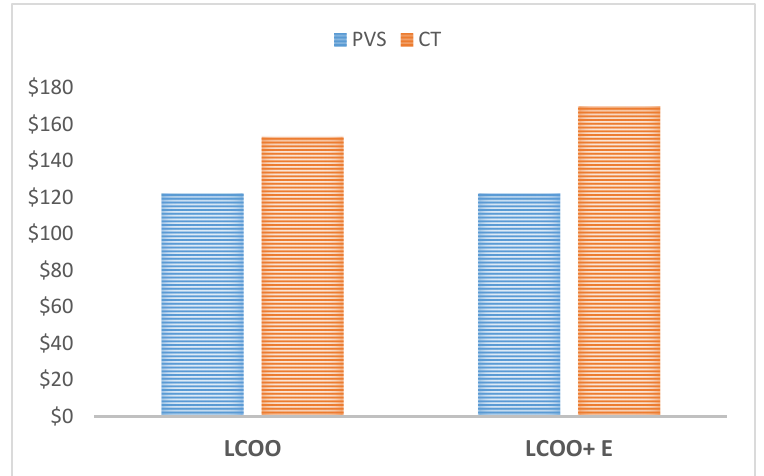
Figure 12. Lifetime cost of operation (LCOO) comparison between PVS (a 50 MW AC PV with 60 MW/240 MWh BESS) and Conventional CT (70 MW) power plants in M$ over twenty year system life without and with considering yearly environmental cost of operation due to emissions.